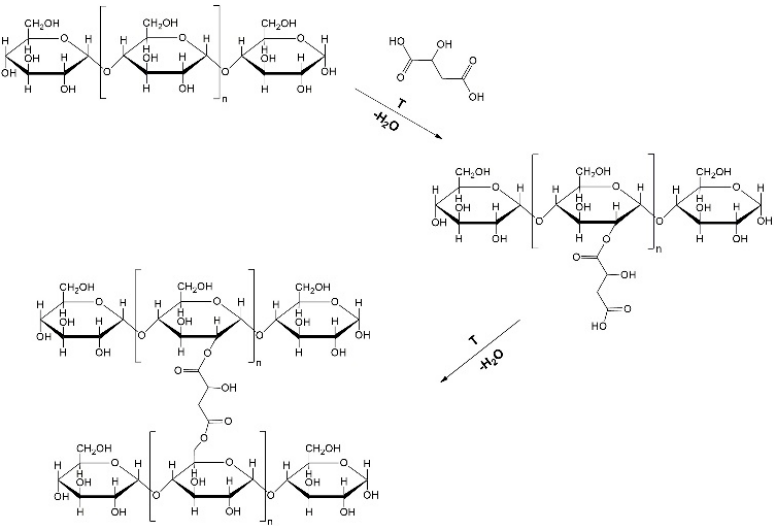
Figure 1. Mechanism of starch esterification by malic acid.